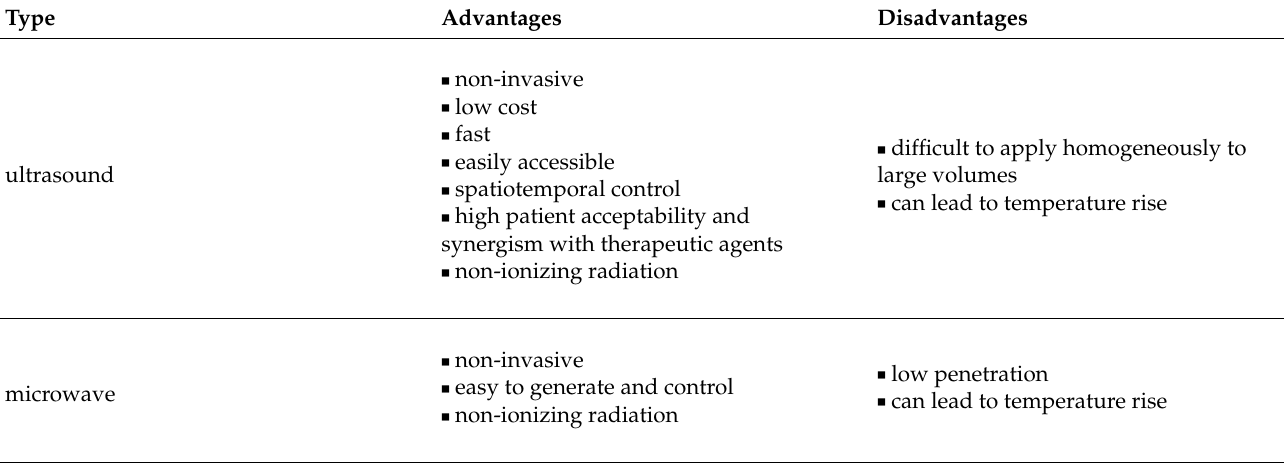
Table 1. The advantages and disadvantages of drug delivery trigger mechanisms.